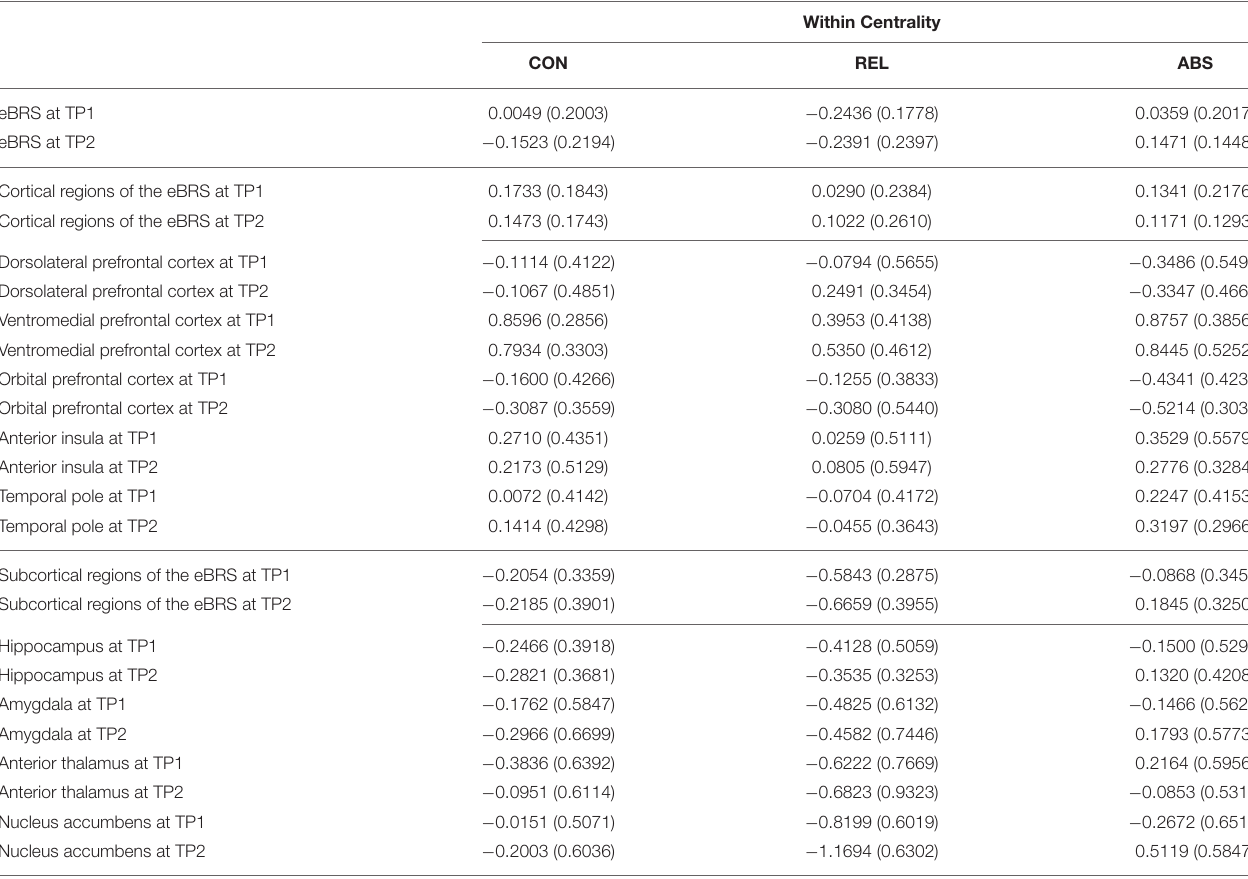
TABLE 6 | The within centrality of the extended brain reward system (eBRS) and its constituent brain regions in the controls (CON), relapsers (REL), and abstainers (ABS) at 1 month (TP1) into treatment and at follow-up 3 months later (TP2).